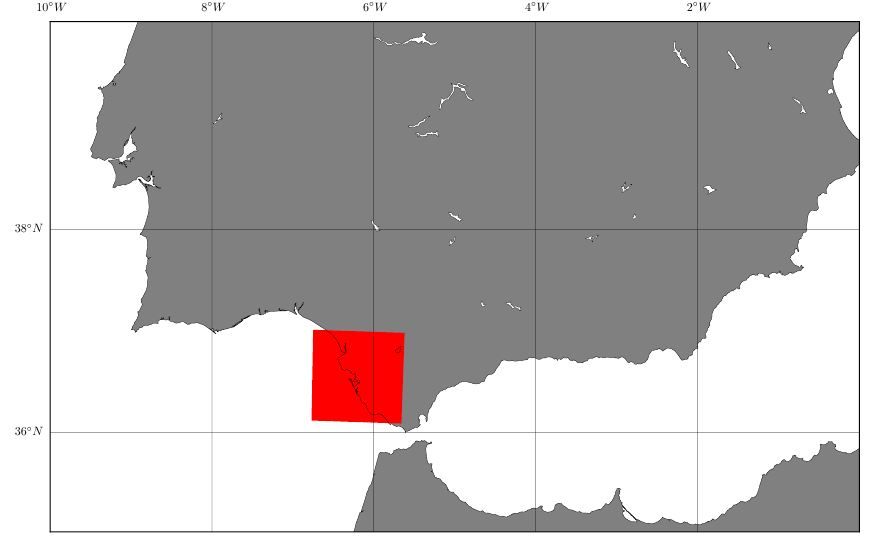
Figure 12. Location of evaluation area near Cádiz (South-West